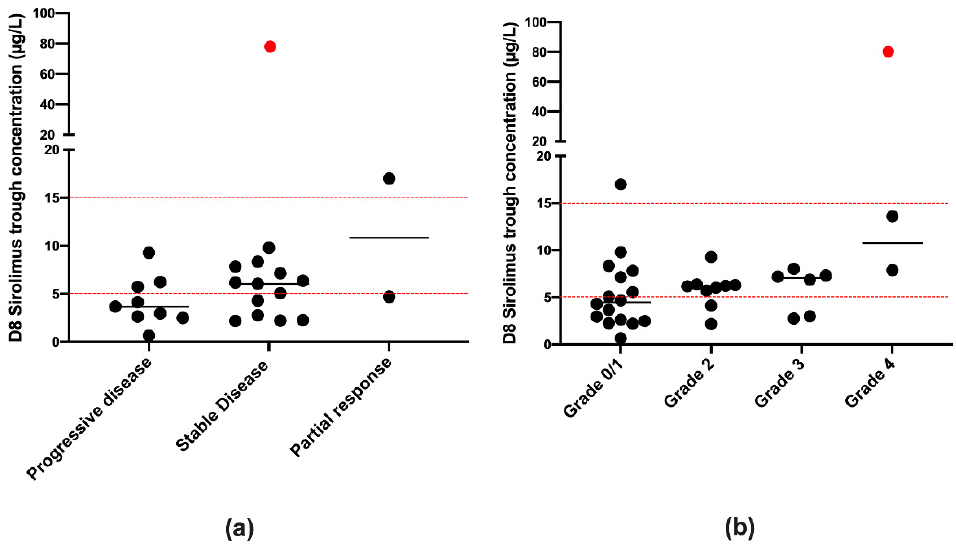
Figure 5. Efficacy and toxicities assessment. Representation of sirolimus trough concentrations at steady state (D8) depending on the disease evolution ( a ) and the toxicity ( b ). The red point is an outlier and corresponds to a very high trough concentration (79.6 µg/L) of a patient presenting stable disease evolution and high toxicity. Red dash lines represent sirolimus therapeutic range used in transplantation (5–15 µg/L).